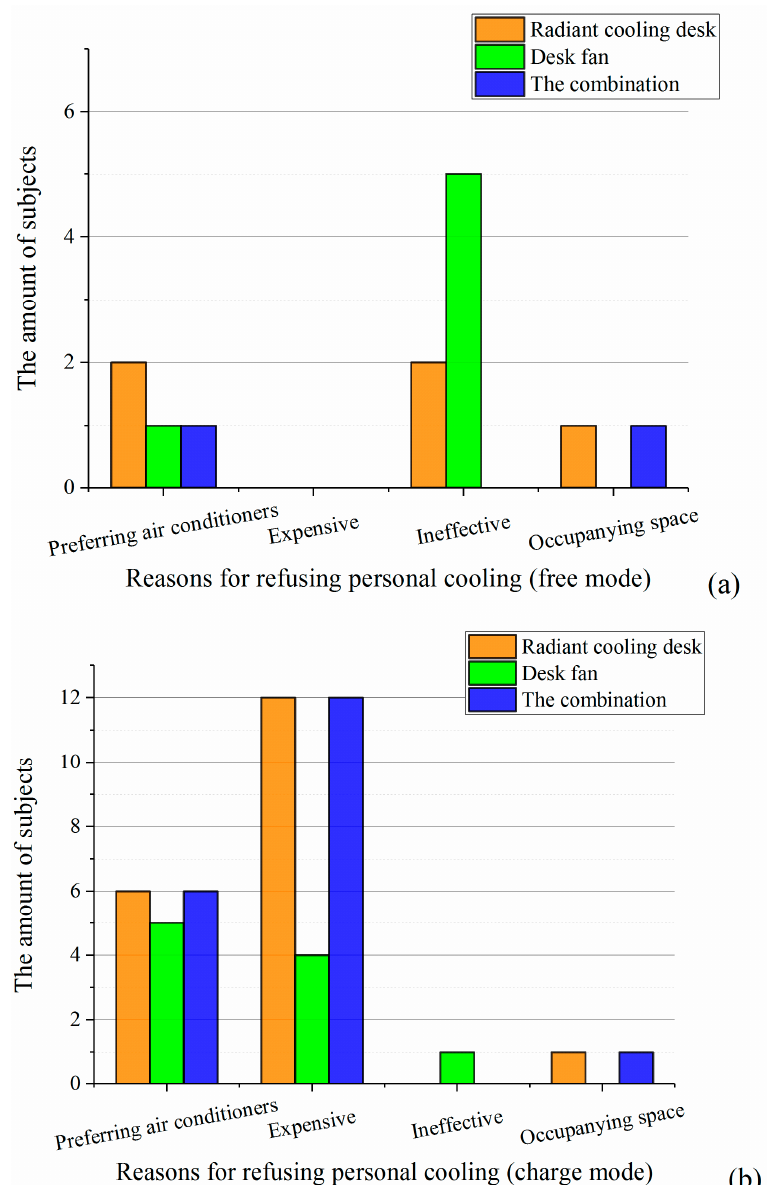
Figure 12. Reasons for refusing to adopt personal cooling systems: ( a ) free mode; ( b ) charge